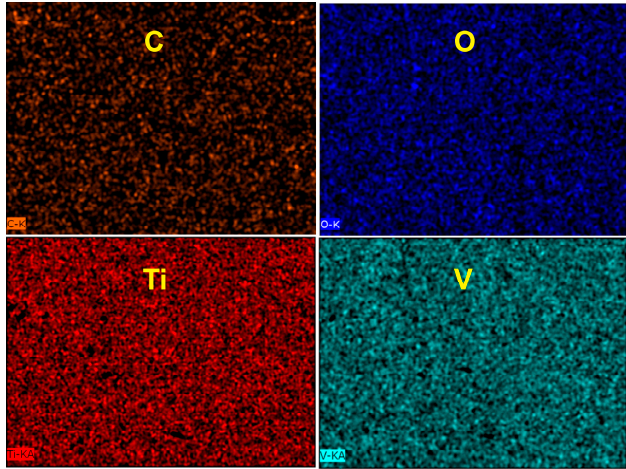
Figure 3. Energy-dispersive X-ray spectroscopy (EDX) mapping of the Ti 85 V 15 _40V_5% sample.